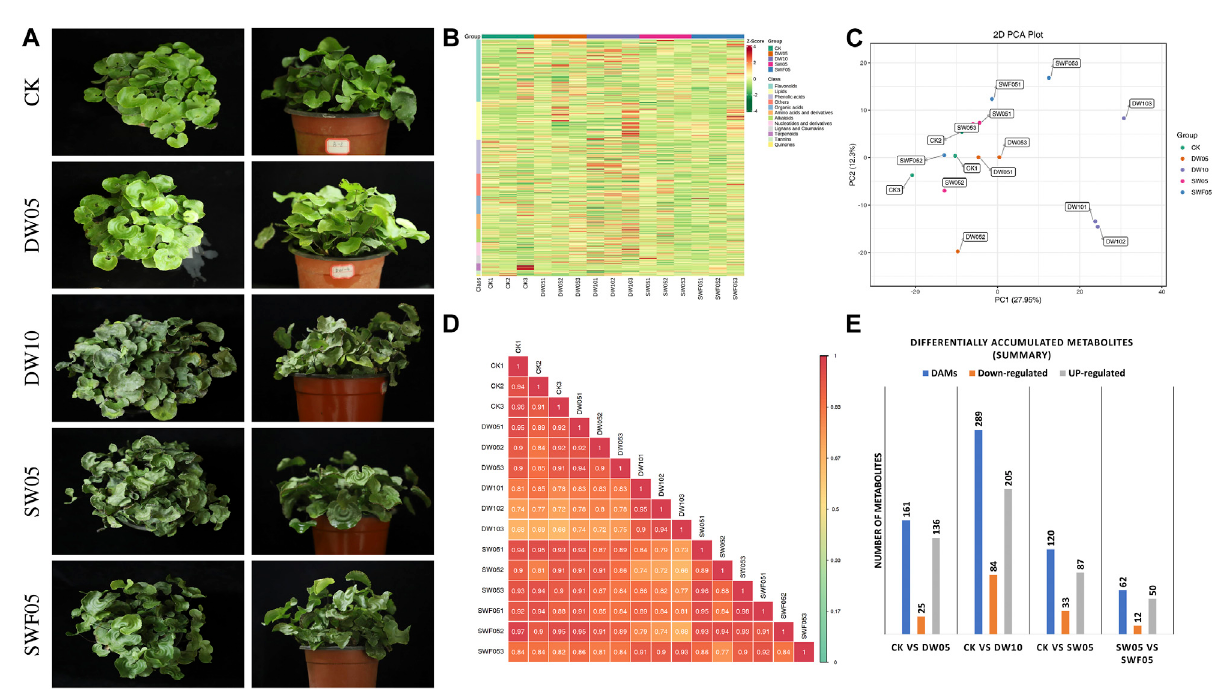
FIGURE 1 Overview of the observable phenotypes and summary of the metabolomic pro fi les in control and treatments. (A) Pictures of the Adiantum plants grown under different stress and control conditions. (B) Heatmap of the relative intensities of the metabolites accumulated in Adiantum leaves after differenttreatments. (C) Principalcomponentanalysisand (D) HeatmapofthePearson ’ sCorrelationCoef fi cientforthedetectedmetabolitesinAdiantum leaves after different stress treatments. (E) Summary of the differentially accumulated metabolites in Adiantum leaves under different stress conditions. Where, CK = control, DW05 = half-waterlogging for 5 days, DW10 = half-waterlogging for 10 days, SW05= drought for 5 days, and SWF05 = day fi ve after